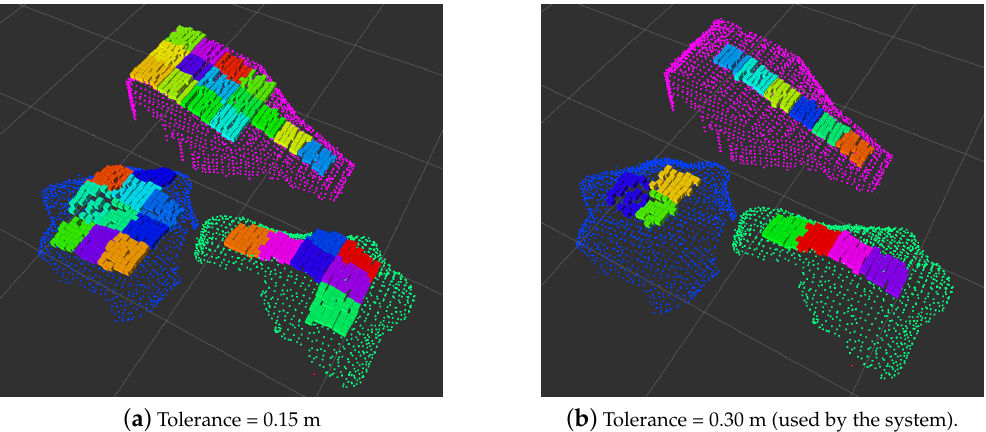
Figure 14. Results of Rule 3 with different